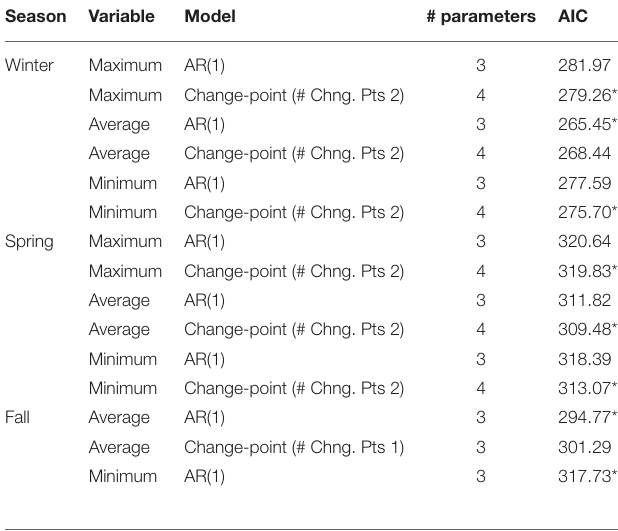
TABLE 7 | Akaike Information Criterion (AIC) values for PDO data for AR (1) model (auto regressive model of order 1) and change-point model with either two or one change-points computed for variables with significant change-point (s) in a given